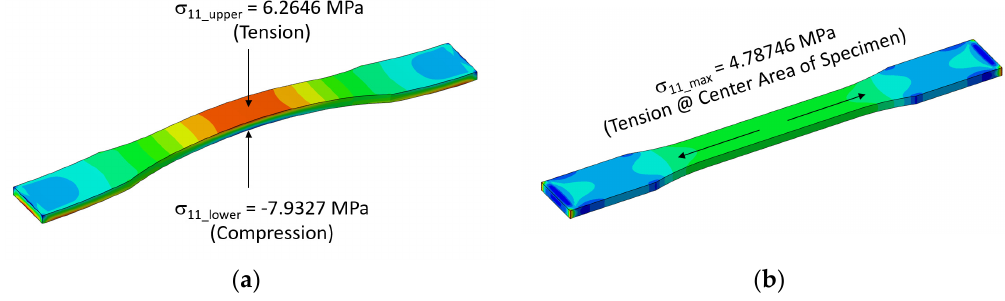
Figure 4. Through thickness variation of principal stress at the center point of the tensile specimen: Figure 5. Principle stress ( 𝜎 (cid:2869)(cid:2869) ) contours: ( a ) temperature rise; ( b ) temperature drop. Figure 5. Principle stress ( σ 11 ) contours: ( a ) temperature rise; ( b ) temperature